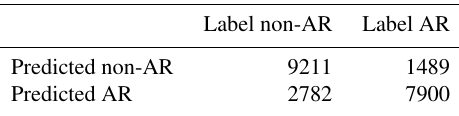
Table B1. Confusion matrix of the method for the testing set – the MERRA-2 data (3-hourly, 50km). It shows the number of correctly recognized (the diagonal) and the number of incorrectly classified events (off-diagonal).